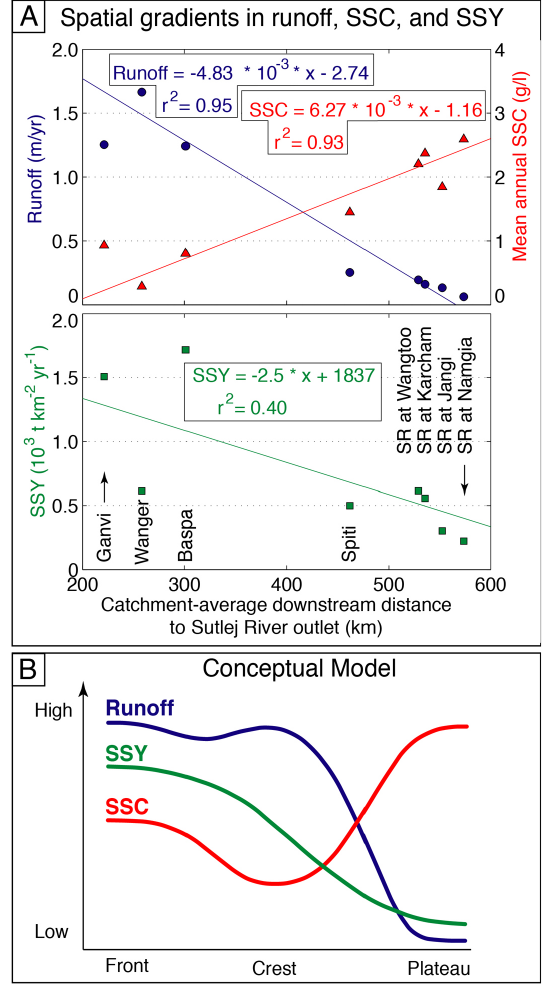
Fig. 8. (A) Spatial gradients in runoff, suspended sediment con- centration (SSC), and effective suspended sediment yield (SSY eff , based on the summer half-year only) for the Sutlej River and tribu- tary catchments. Correlations are weighted by the number of mea- surement years. The correlation is based on the catchment-average downstream distance to the Sutlej River outlet to account for the predominant catchment area location. (B) Conceptual model of the spatial distribution of SSC, runoff, and SSY from the Tibetan Plateau to the Himalayan Crest and the Himalayan